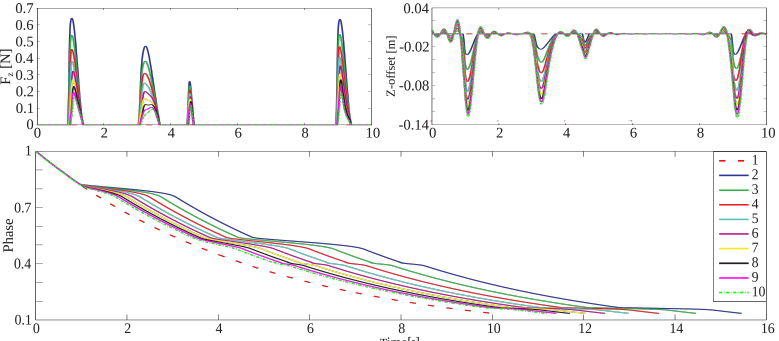
Figure 8. Force adaptation of the proposed framework after nine trials. Top-right : shows how the forces adapt, decreasing from Line -2 to Line -10. Top-left : represents the learned offsets, which increase throughout the trials. Bottom : shows the phase evolution after nine